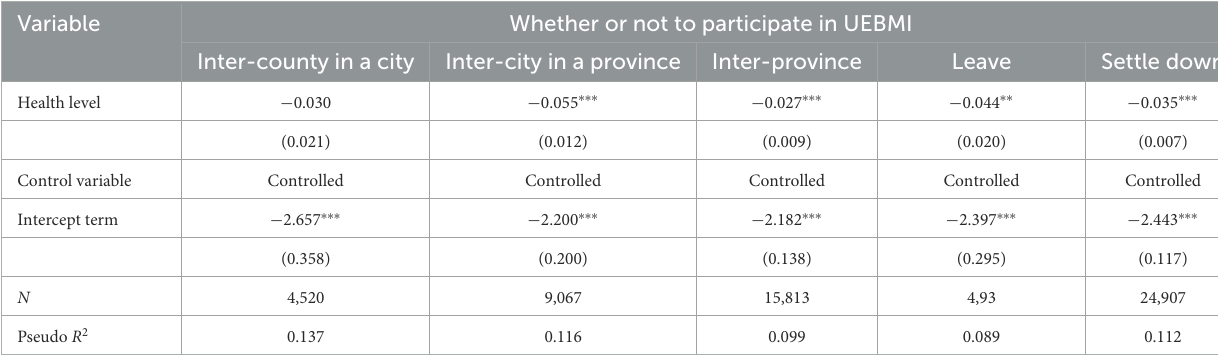
TABLE 8 Heterogeneous effect of migration distance and settlement intention on adverse selection in insured sample.